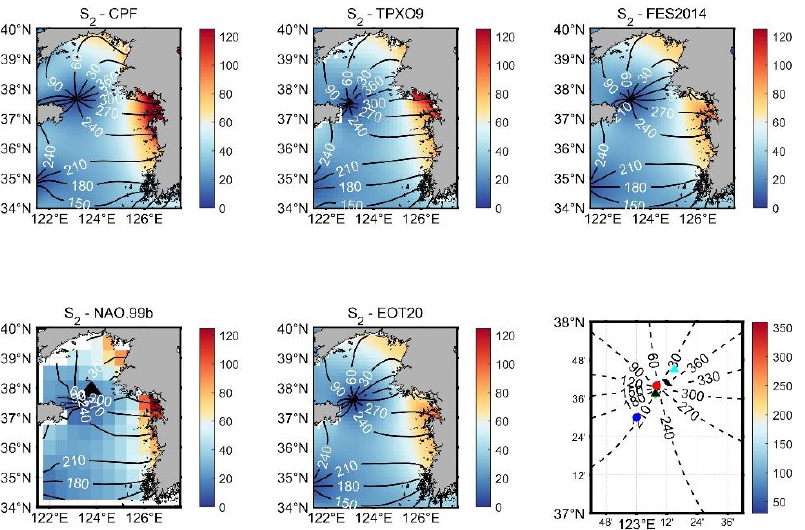
Figure 6. The cotidal charts of the S 2 constituent from the CPF method and the TPXO9, FES2014, NAO.99b and EOT20 models, and the amphidromic points of the CPF method and the four models (unit: cm). The amphidromic points of the FES2014 and EOT20 models are identical.